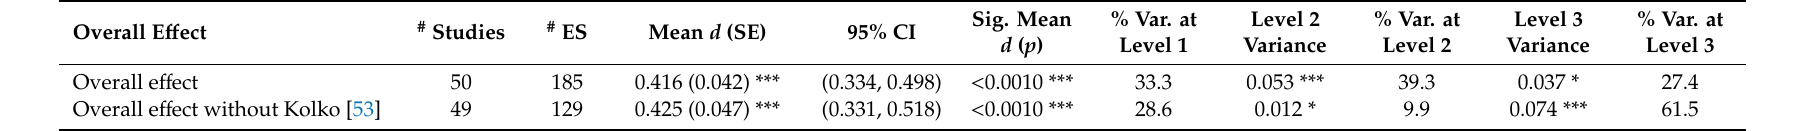
Table 2. Overall e ff ect for parent training programs on child maltreatment and sensitivity analysis.